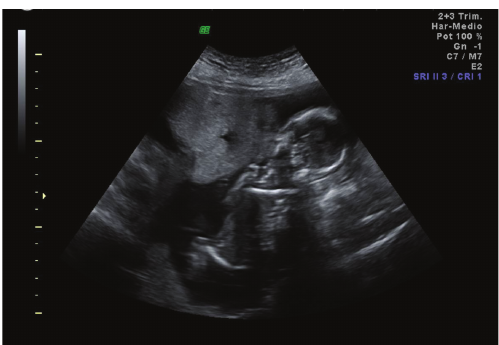
Figure 1: Abdominal ultrasound image showing the myoma in the front face of the uterus that clearly evidences the fetal compression. Both fetal legs and arms are in a hyperflexion position.